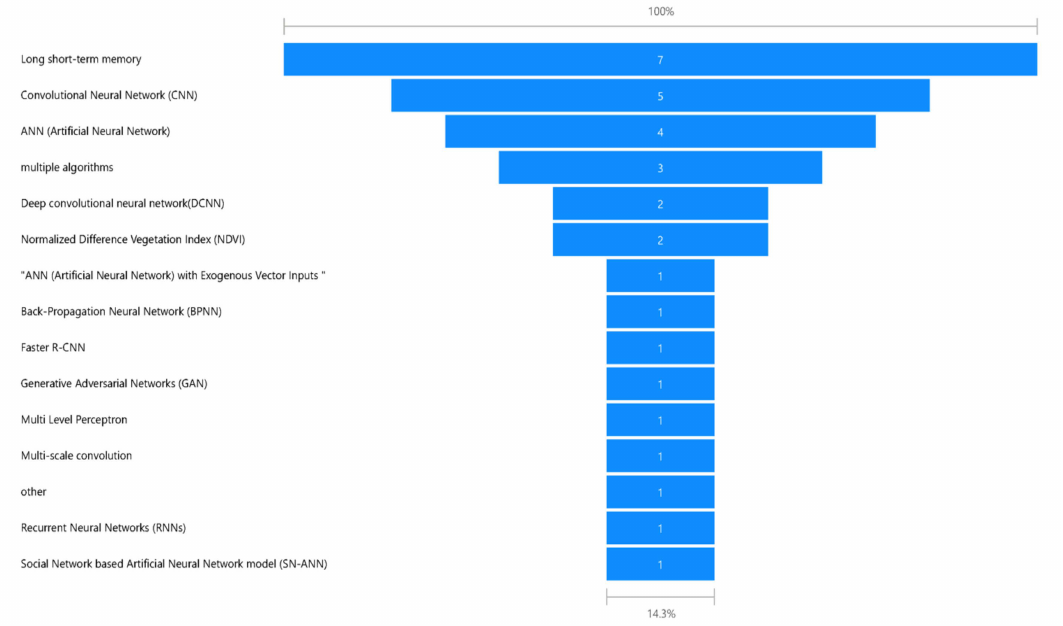
Figure 9. The ML techniques and algorithms used for deep learning applications.